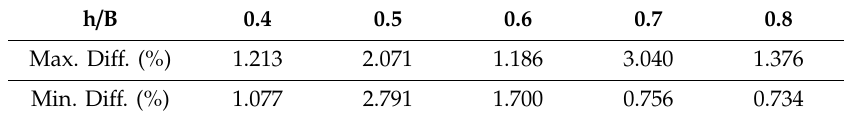
Table 8. Maximum and minimum sloshing height predicted by the proposed equation according to h /